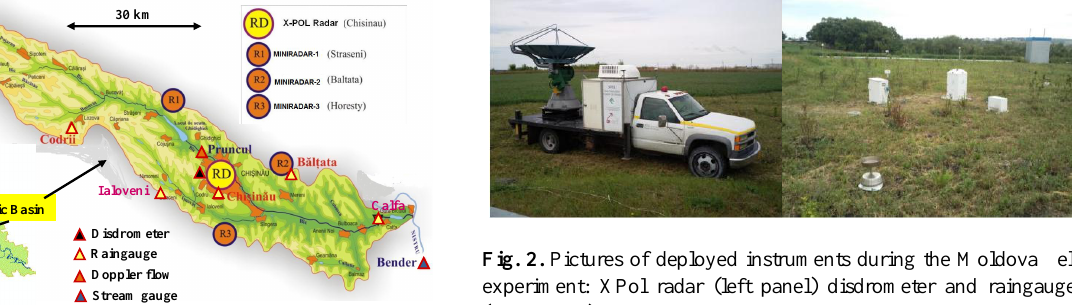
(right panel) located at Chisinau